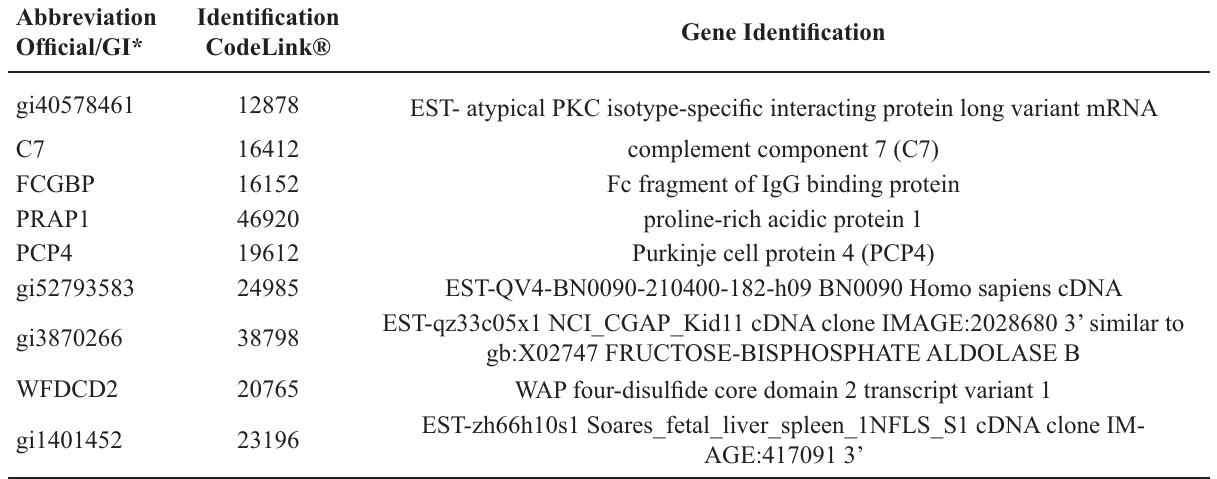
Table 1 – Genes with lower expression from Low-risk to metastatic stage.